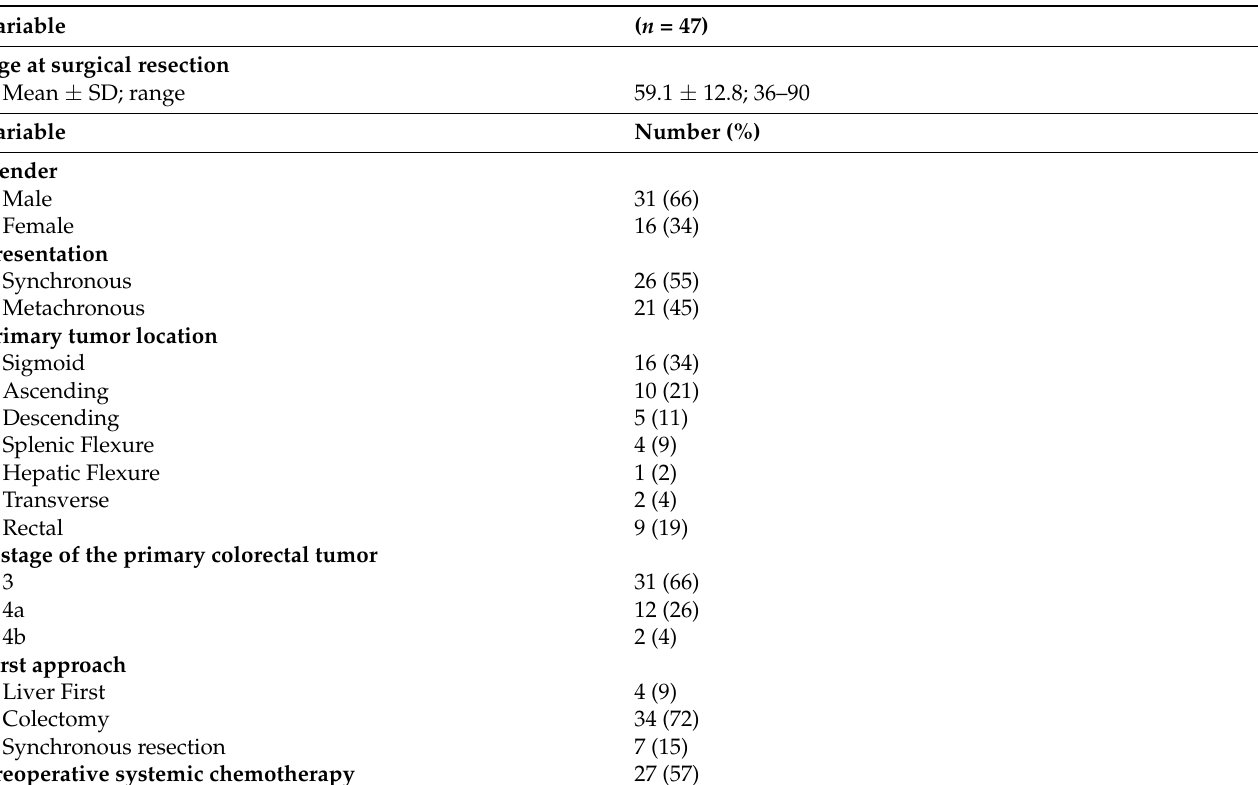
Table 1. Demographic and clinical